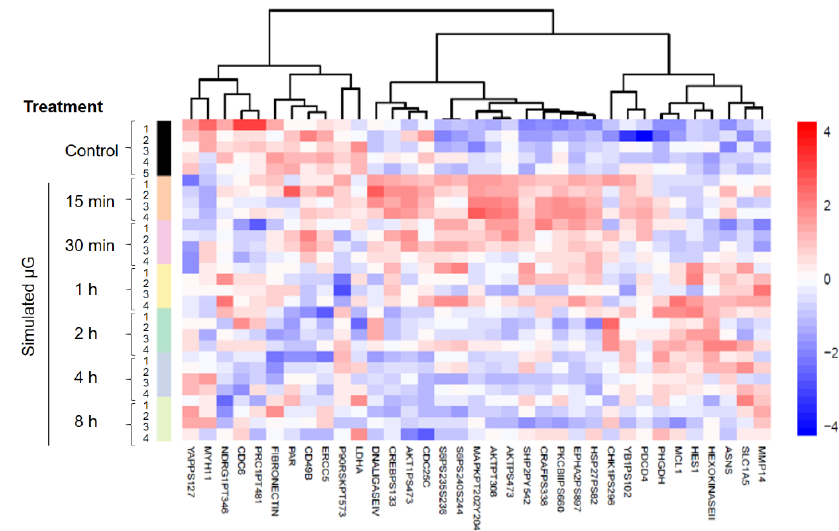
Figure 1. One-way supervised heatmap shows the expression patterns of the significant proteins identified by LIMMA (FDR < 0.05). Cells were treated with S μG for 15 min, 30 min, 1 h, 2 h, 4 h , and 8 h. Control samples were cells grown at 1G. Each group has over four samples.